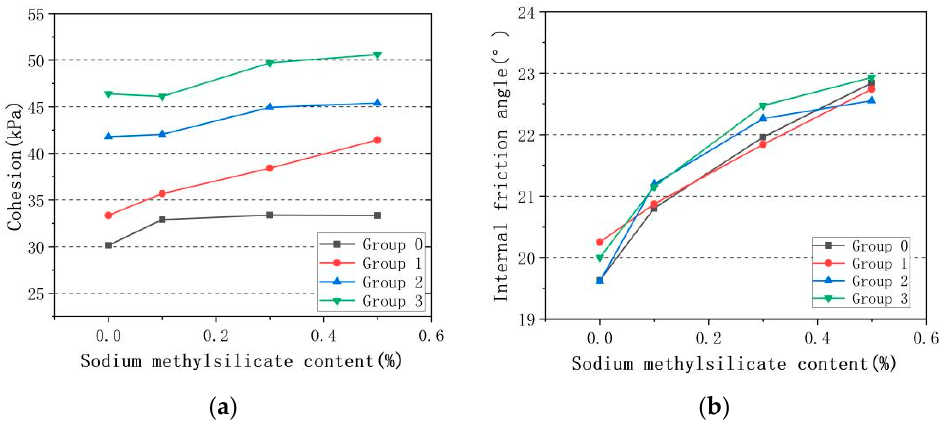
Figure 5. Variation curve of cohesion and internal friction angle with sodium methyl silicate: ( a ) variation curve of cohesion with sodium methyl silicate; ( b ) Variation curve of internal friction angle with sodium methyl silicate.